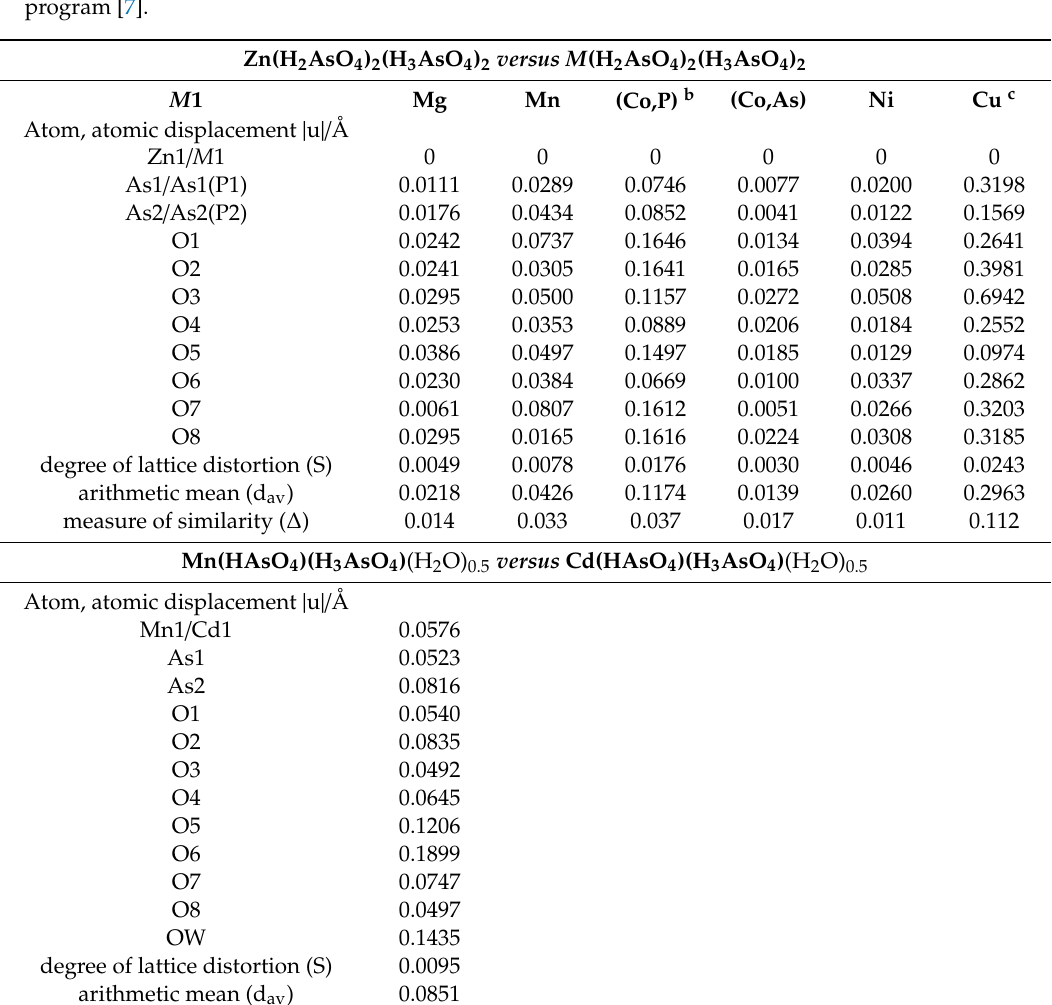
Table 4. Numerical details from the comparisons of the crystal structure of Zn(H 2 AsO 4 ) 2 (H 3 AsO 4 ) 2 a with isotypic structures in the M (H 2 X O 4 ) 2 (H 3 X O 4 ) 2 series ( M = Mg, Mn, Co, Ni, Cu; X = As, P), and between Mn(HAsO 4 )(H 3 AsO 4 )(H 2 O) 0.5 and Cd(HAsO 4 )(H 3 AsO 4 )(H 2 O) 0.5 using the compstru program